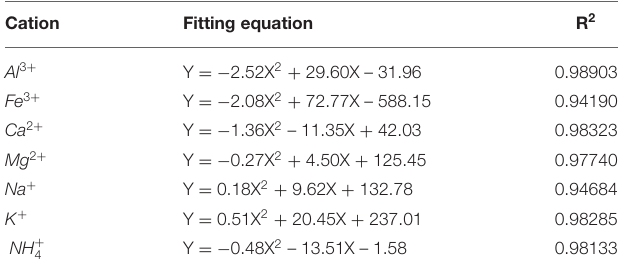
TABLE 2 | The fitting equation of cationic zeta potential—leaching